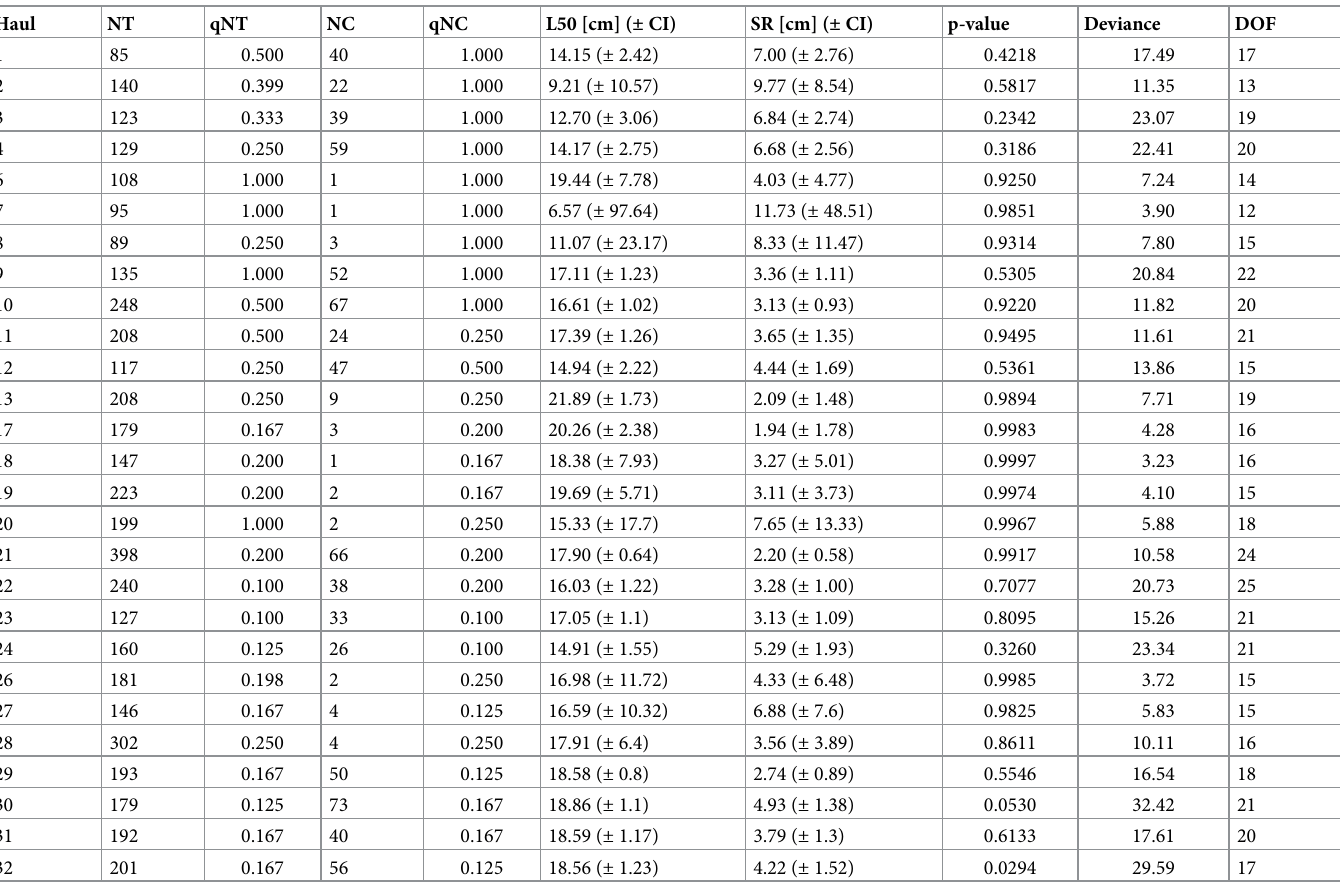
Table 8. Estimated selection parameters and fit statistics for the deep-water rose shrimp (27 hauls).